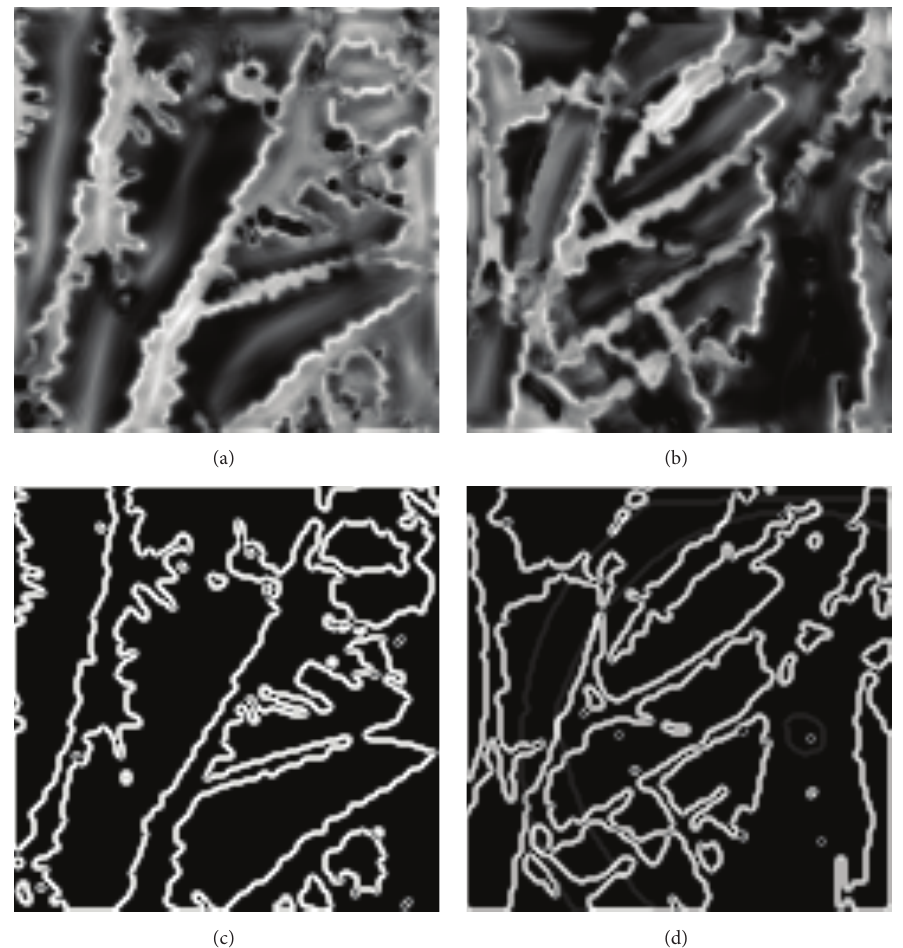
Figure 7: Phase congruency of (a) test image and (b) matched image. Gradient magnitude of (c) test image and (d) matched image.